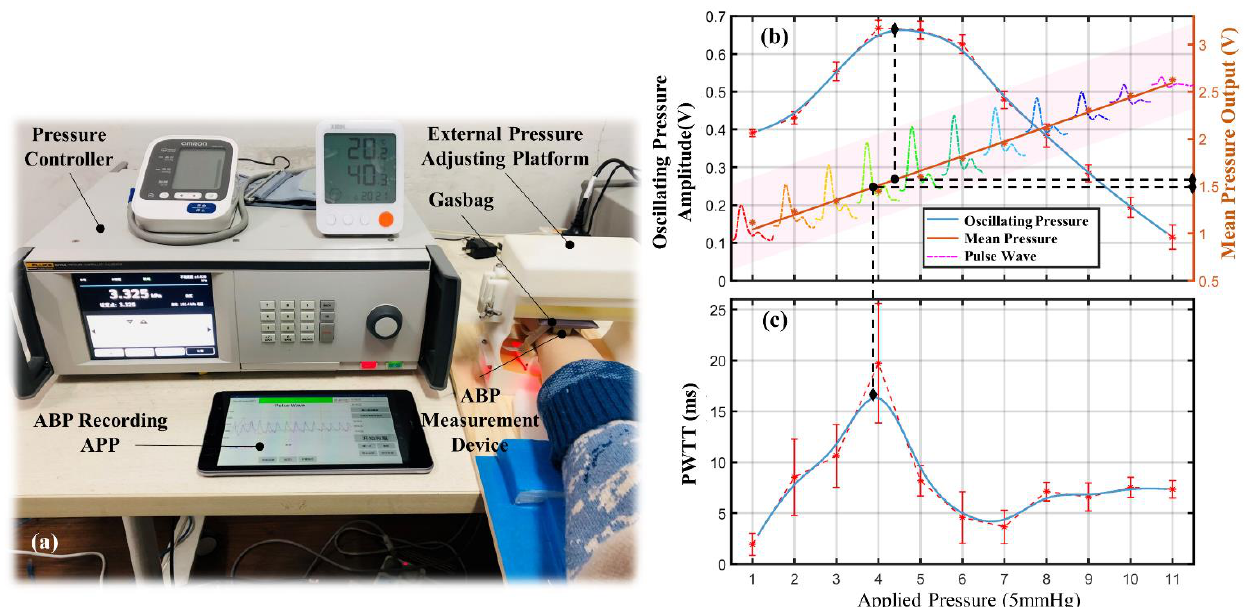
Figure 9. Pulse characteristics at different applied pressures.( a ) Experimental setup for initial BP calibration. ( b ) Mean pressures and oscillating pressures. ( c ) PWTT.